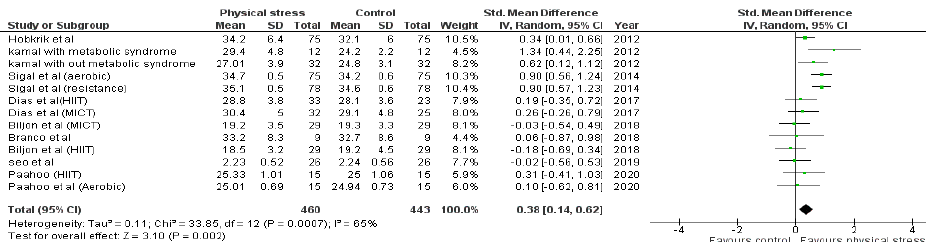
Figure 2. Forest plot showing the results for body weight.